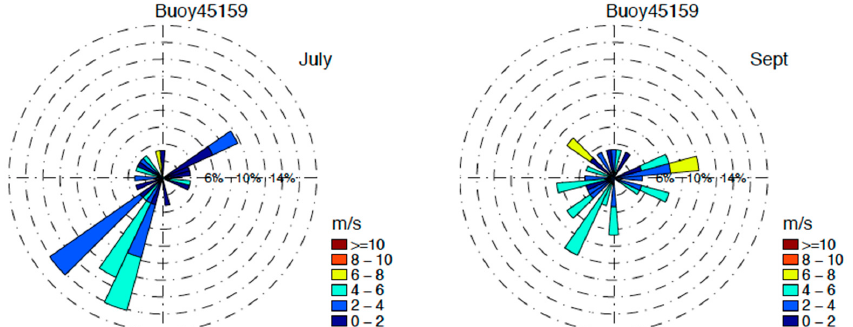
Figure 5. Upper panel: comparison of the daily averaged wind speeds from NDBC Buoy 45159 and from the Climate Forecast System Reanalysis (CFSR) reanalysis wind speed at the buoy location. Lower panel: wind rose plots based on the same dataset. The length of each “spoke” around the circle represents the frequency (%) with which the wind blows from that direction. Each concentric circle represents a different frequency, increasing from zero at the center to higher frequencies at the outer circles. All wind roses use 16 cardinal directions (e.g., north (N), north-northeast (NNE), northeast (NE), etc.). Wind speeds are presented in 2-m/s bins using the color bar at the lower right.